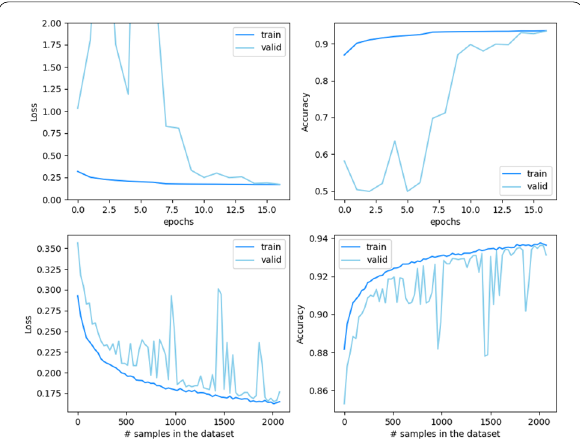
Fig. 12 Top left: training and validation loss. Top right: training and validation accuracy. Bottom left: loss for different dataset sizes. Bottom right: accuracy for different dataset